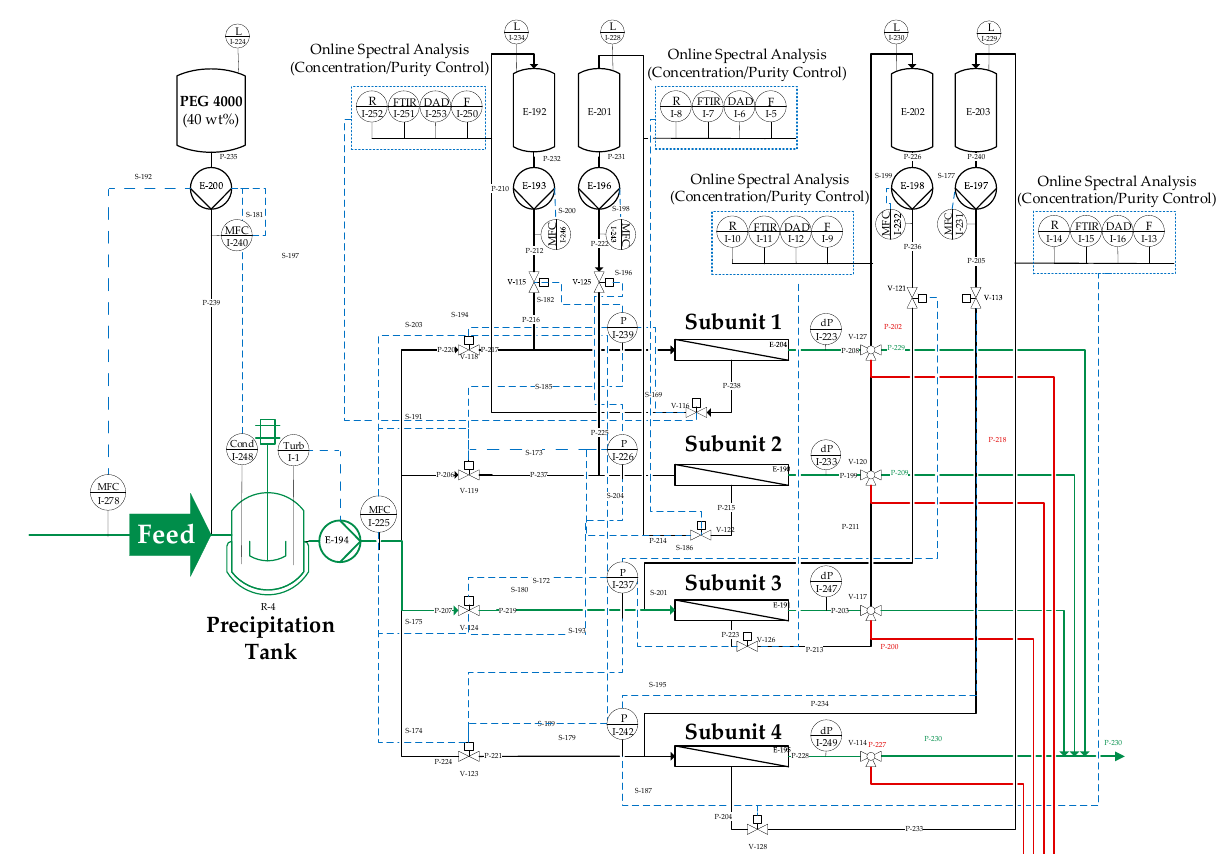
Figure 19. Process control strategy for the precipitation unit including online spectral analysis measuring points. Abbreviation: MFC = mass flow controller; Cond = conductivity probe; Turb = turbidity probe; R = Raman; FTIR = Fourier transform infrared spectros- copy; DAD = diode array detector; F = fluorescence; P = pressure sensor; L = level sensor. The presented APC concept has shortly been published previously [6].